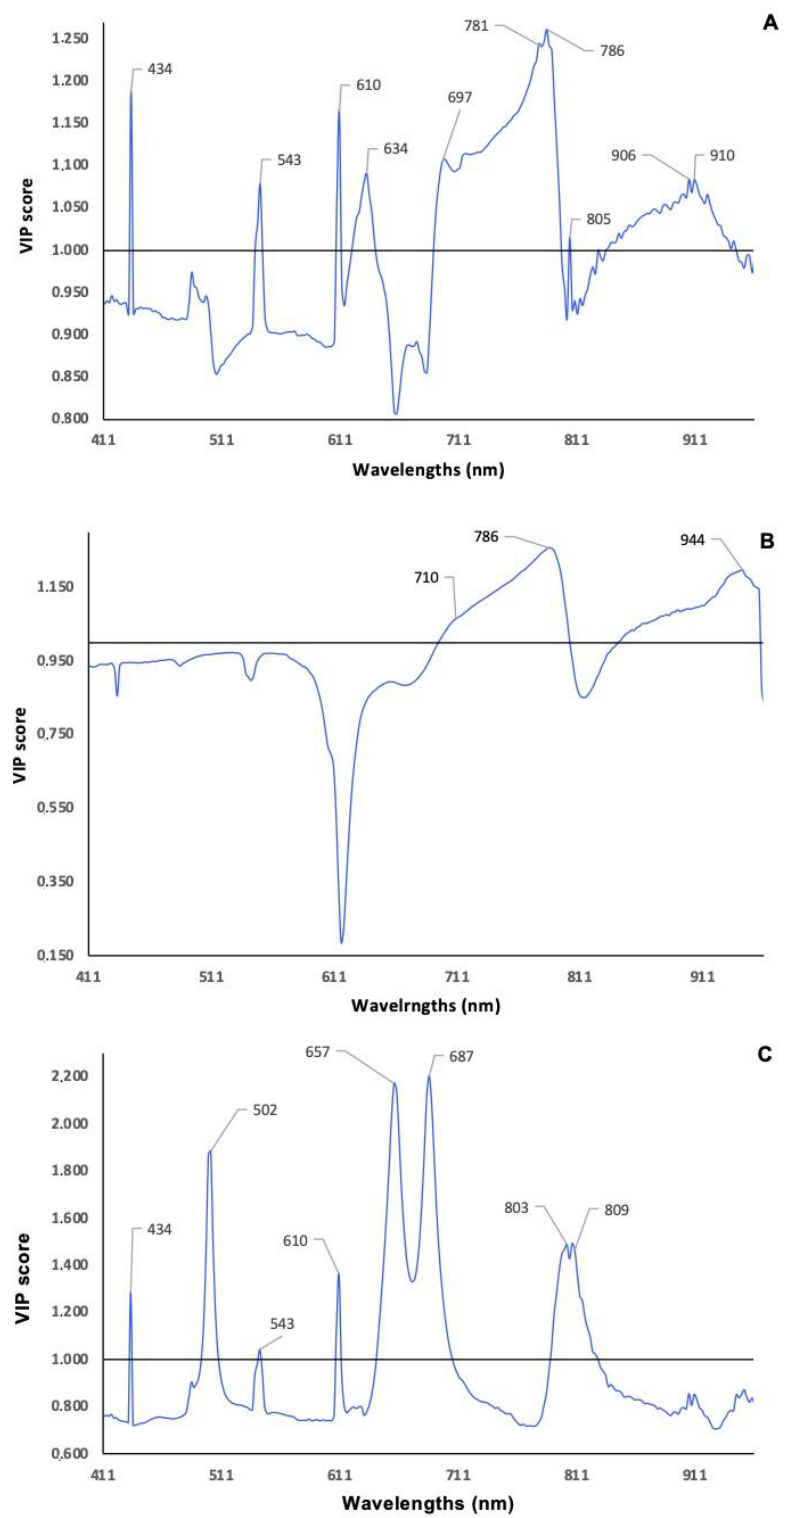
Figure 6. Values of Variable Importance in Projections (VIP) scores for all wavelengths for predicting quality attributes in table grape for the quality attributes Total Flavonoids ( A ), Total Anthocyanins ( B ), and Total Soluble Solids TSS ( C ).